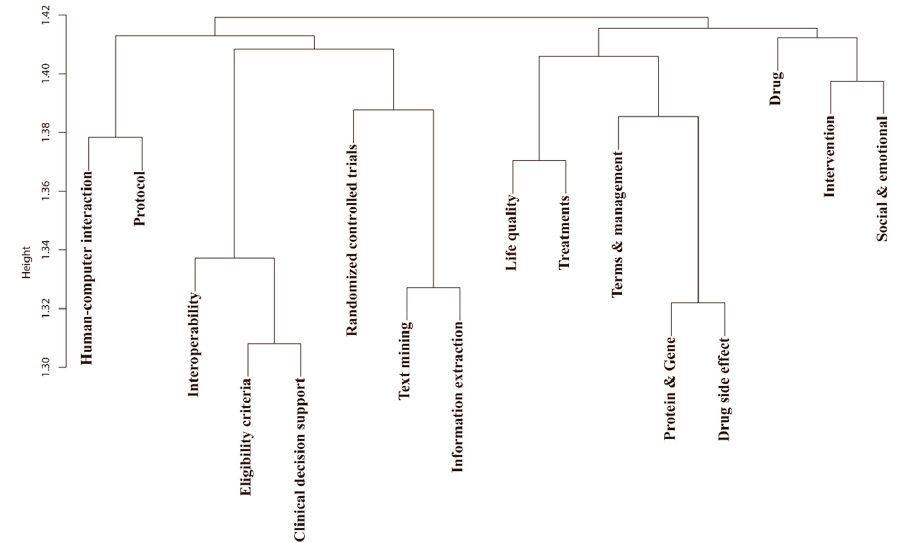
Figure 10. Hierarchical clustering results based on the document-topic distribution matrix.